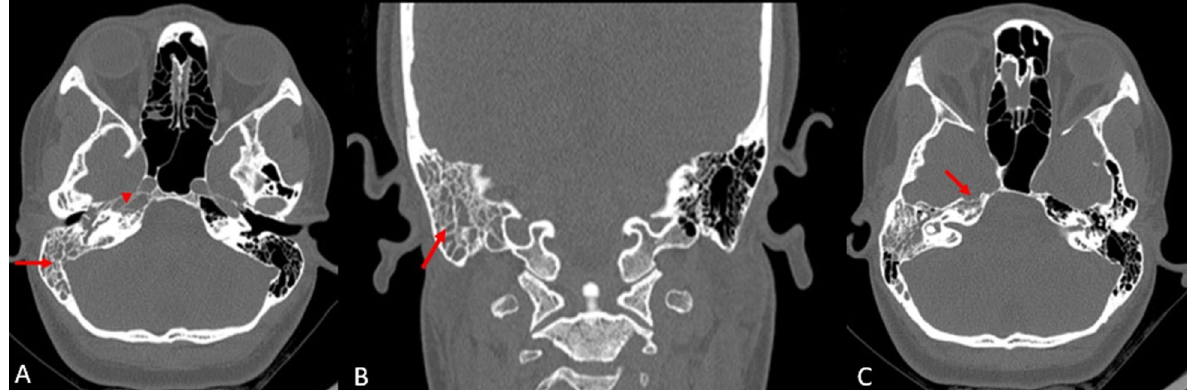
Fig. 1 A 26-year-old female presented with history of right sided rhinorrhoea. A Plain CT PNS and temporal bone axial section showing bilateral hyper-pneumatized petrous bones with overcrowding of the right mastoid air cells (red arrow), opacification of the hyper-pneumatized petrous bone (red arrow head) and mild right ethmoid sinusitis. B Plain CT temporal bone coronal section demonstrating the overcrowding of the right mastoid air cells by mucosal thickening (red arrow). C Plain CT PNS and temporal bone axial section demonstrating the scalloping along the antero-medial aspect of the right petrous bone (red